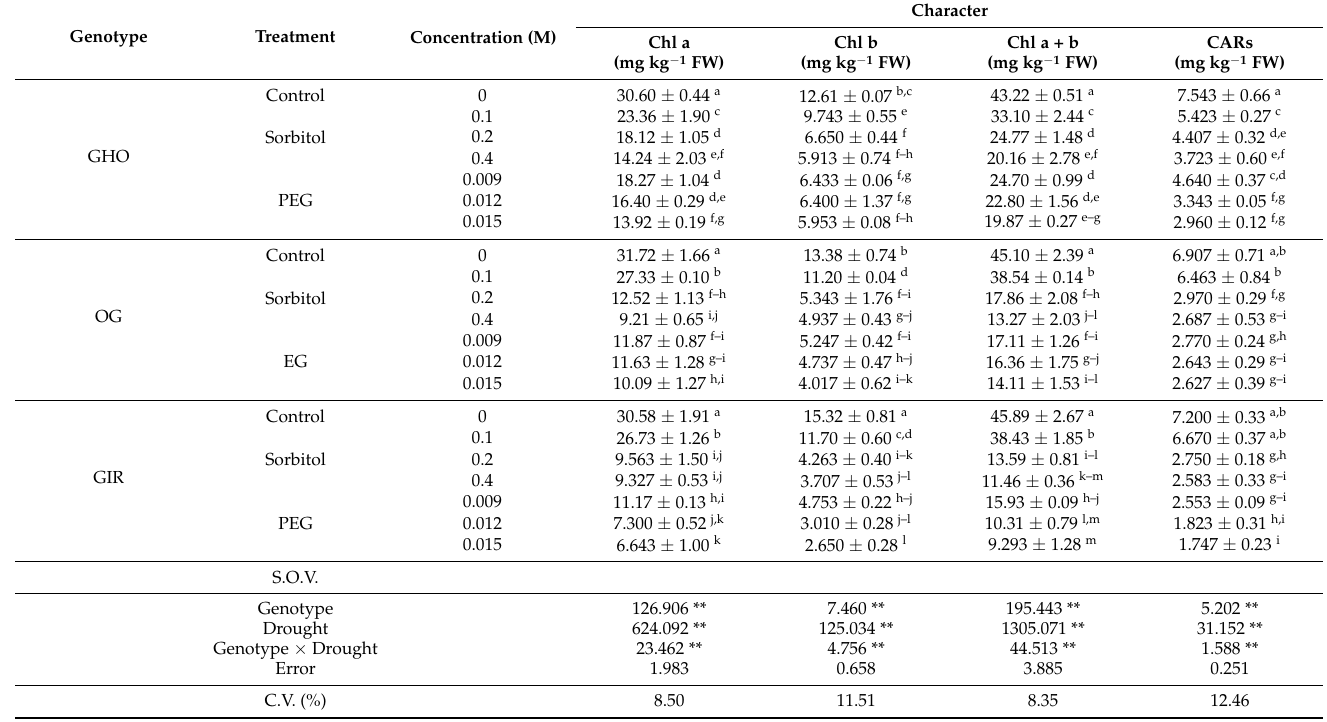
Table 2. The effect of drought stress induced by sorbitol and PEG on photosynthesis pigments content in three melon genotypes under in vitro culture